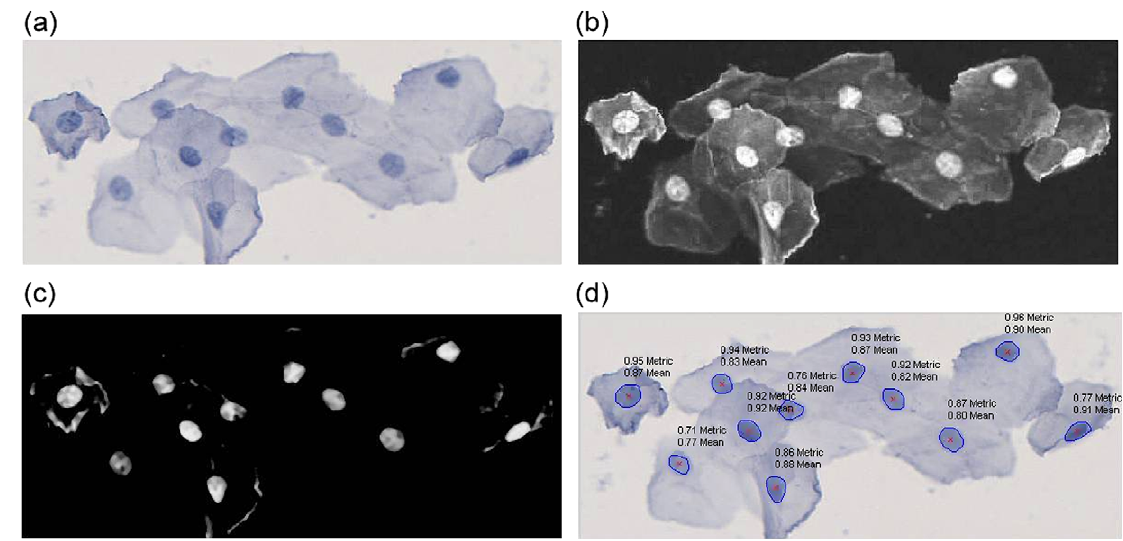
Fig. 4. Segmentation and measurement of individual nuclei. (a) Original image of a cell cluster, (b) the probability (white) of a pixel belonging to a nucleus is calculated based on the HSV color space, (c) subtracting a pixel intensity corresponding to the probability of a pixel to belong to the cytoplasm (after being mapped to the scale of 0–255) highlights the individual nuclei, (d) mean nucleus probability (‘mean’) and application of roundness-metric (‘metric’) result in probability scores in the range of 0–1 for each nucleus of a cell cluster.